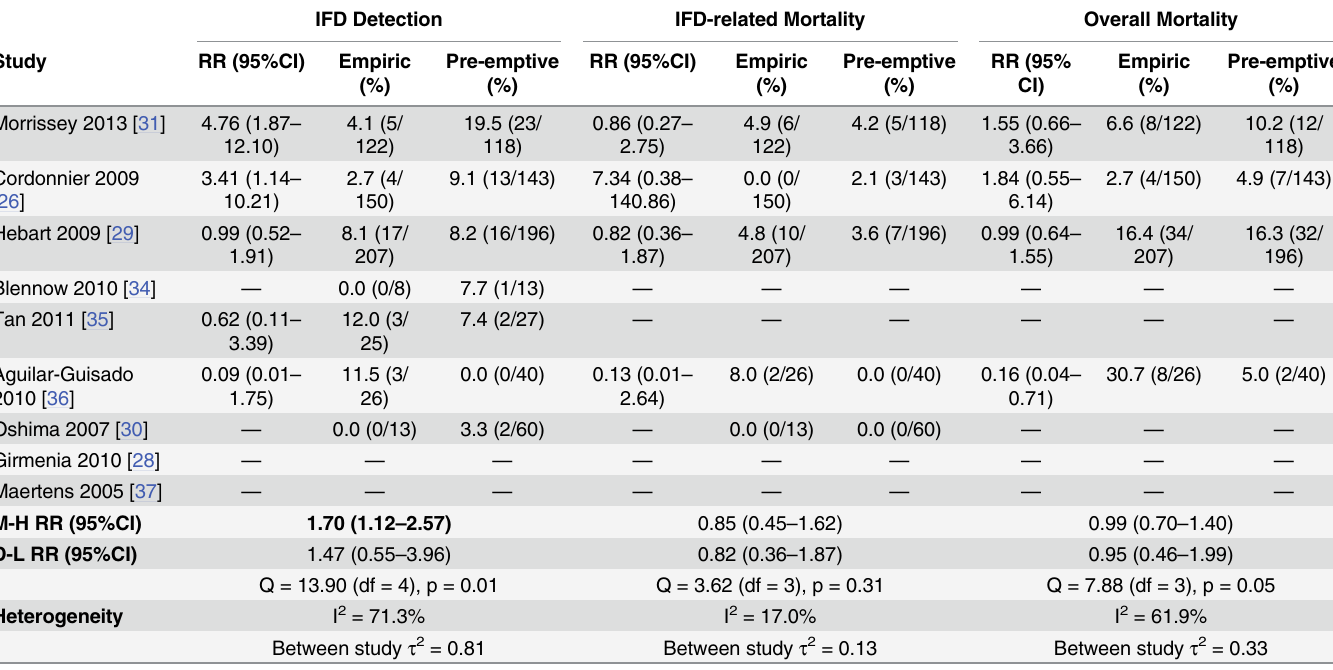
Table 2. Comparison of IFD-related outcomes in empiric versus pre-emptive antifungal therapy in high-risk neutropenic patients. IFD Detection IFD-related Mortality Overall Mortality